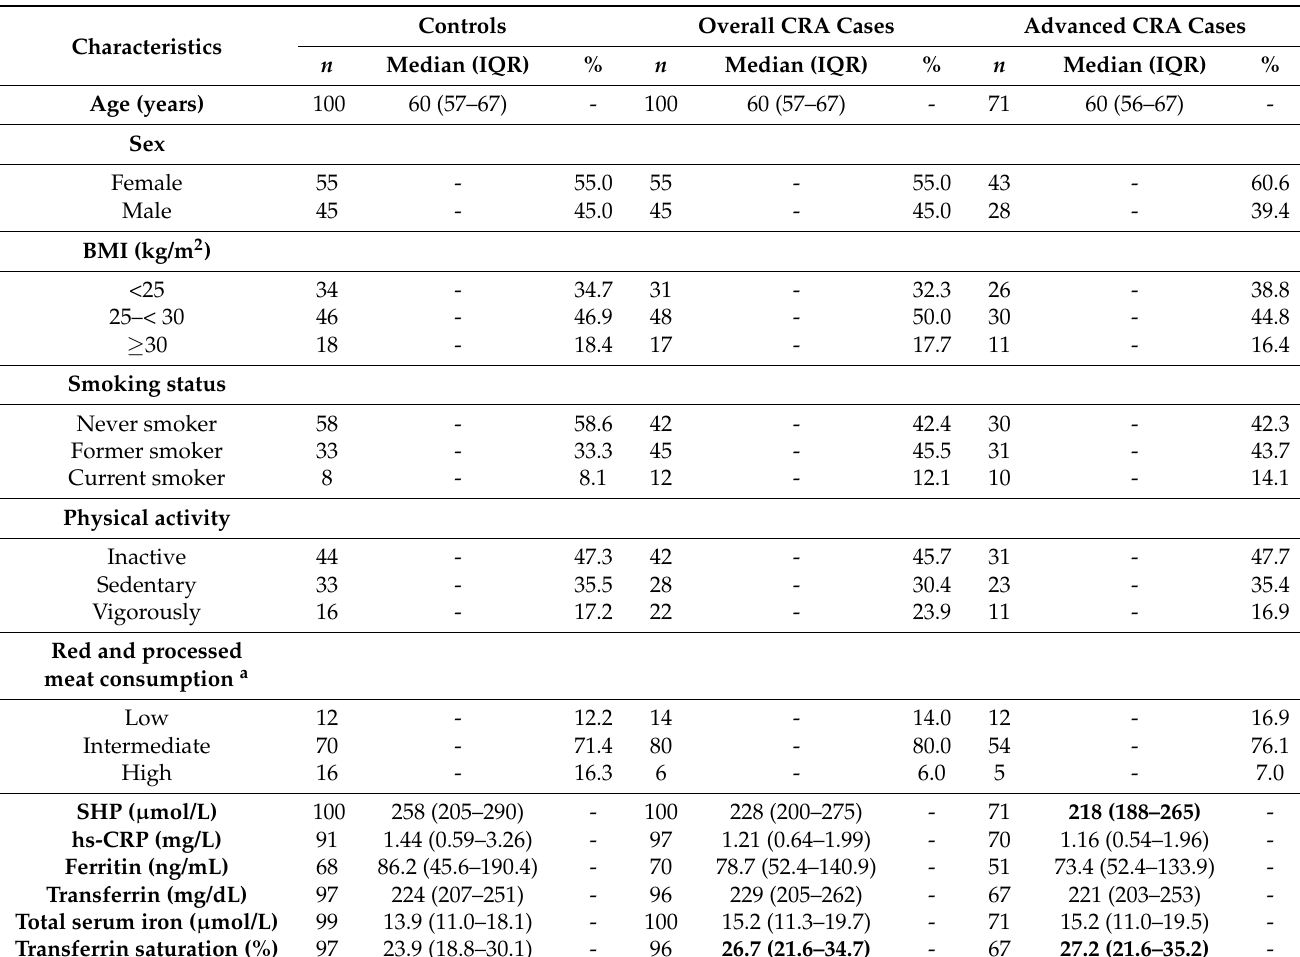
Table 1. Baseline characteristics of adenoma case patients as well as age and sex frequency-matched control participants.